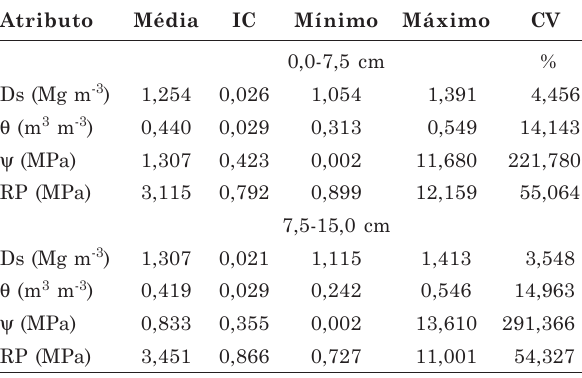
apresentadas na figura 1. Constatou-se que o